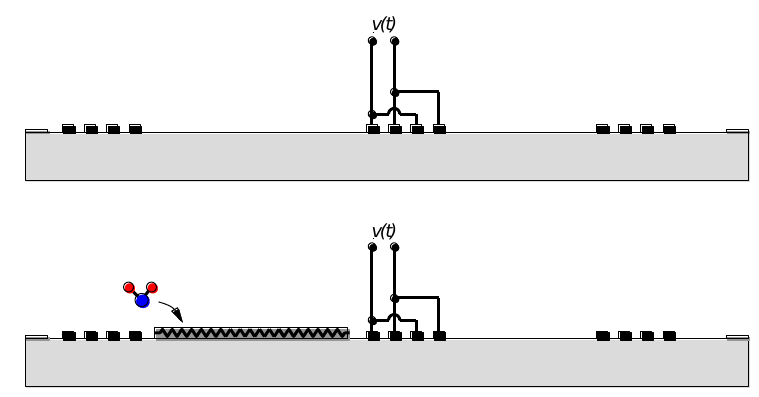
Figure 3. SAW sensors: for sensing of temperature only ( Top ) and for simultaneous gas and temperature sensing ( Bottom